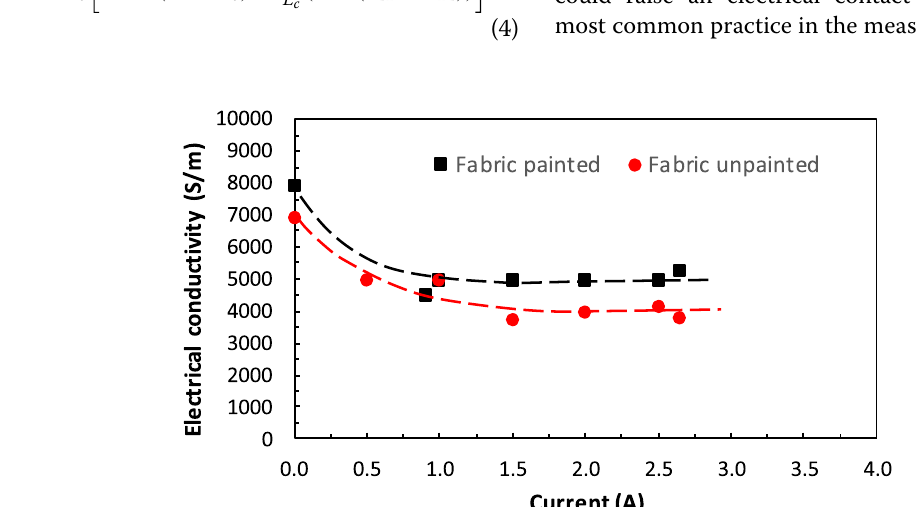
Fig. 4 In-plane electrical conductivities of fabric carbon/epoxy laminates without and with silver paint with 2Nm clamping